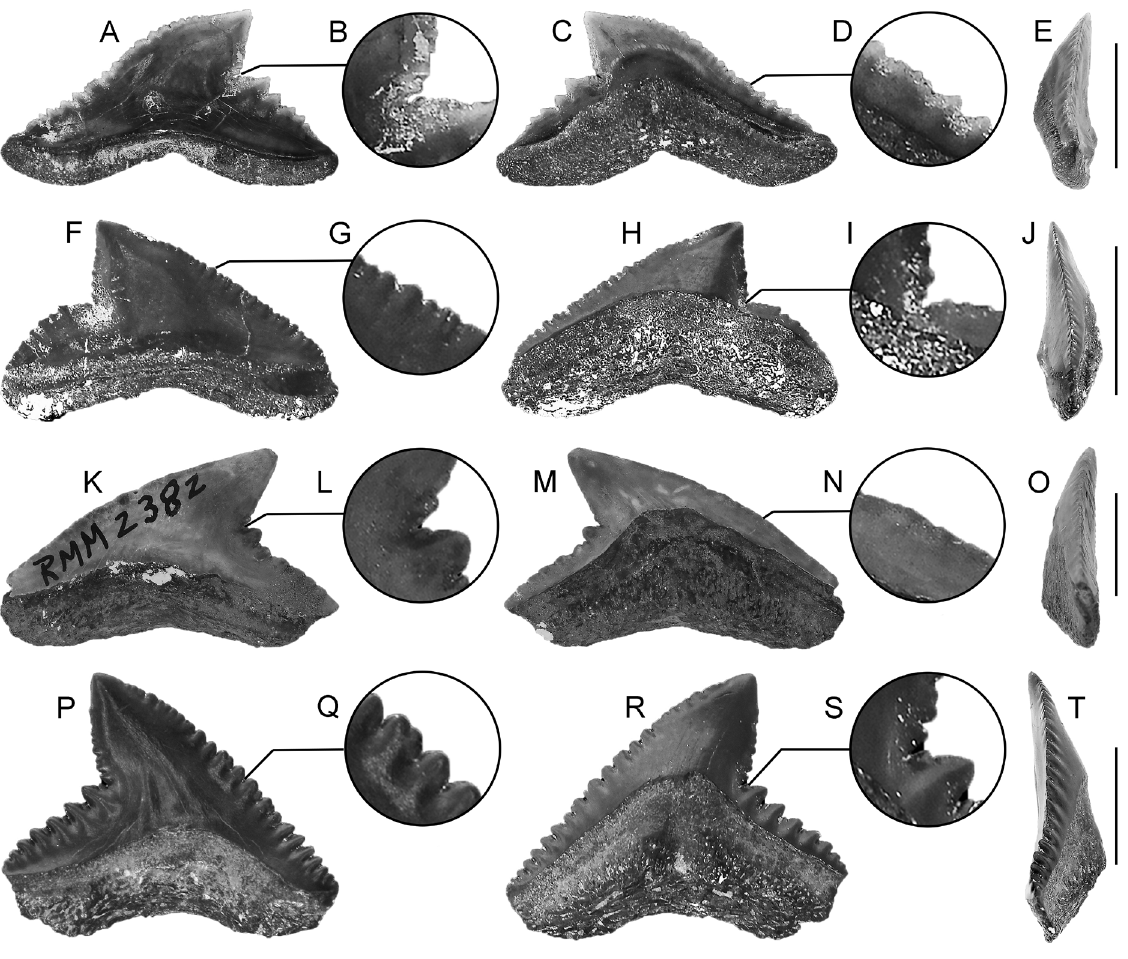
Fig. 36. Galeocerdo clarkensis White, 1956, teeth. A–E . MSC 188.68, lateral tooth, basal